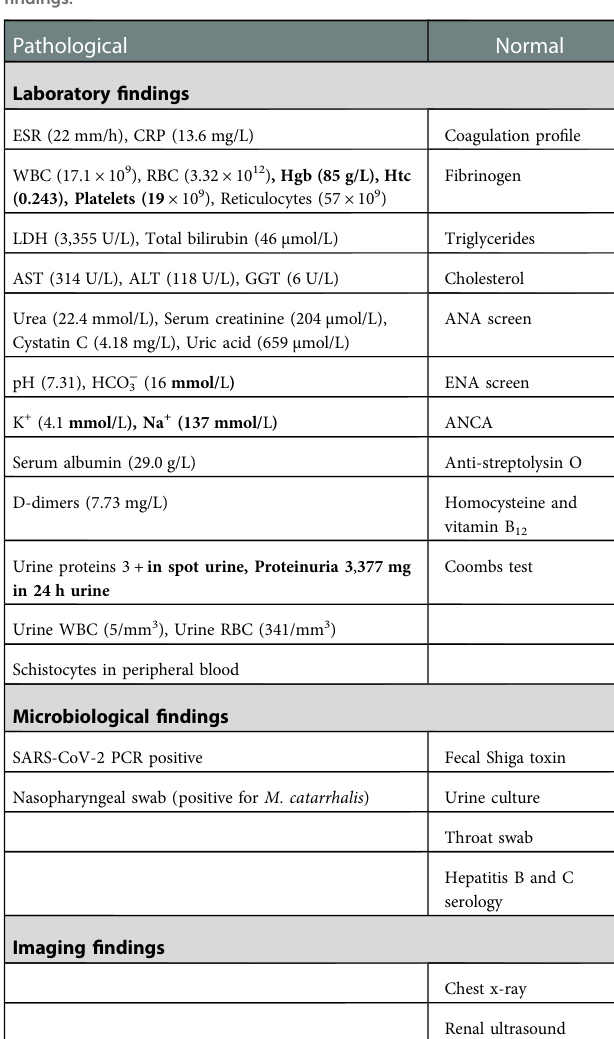
TABLE 2 Initial vital parameters, laboratory, microbiological and imaging fi